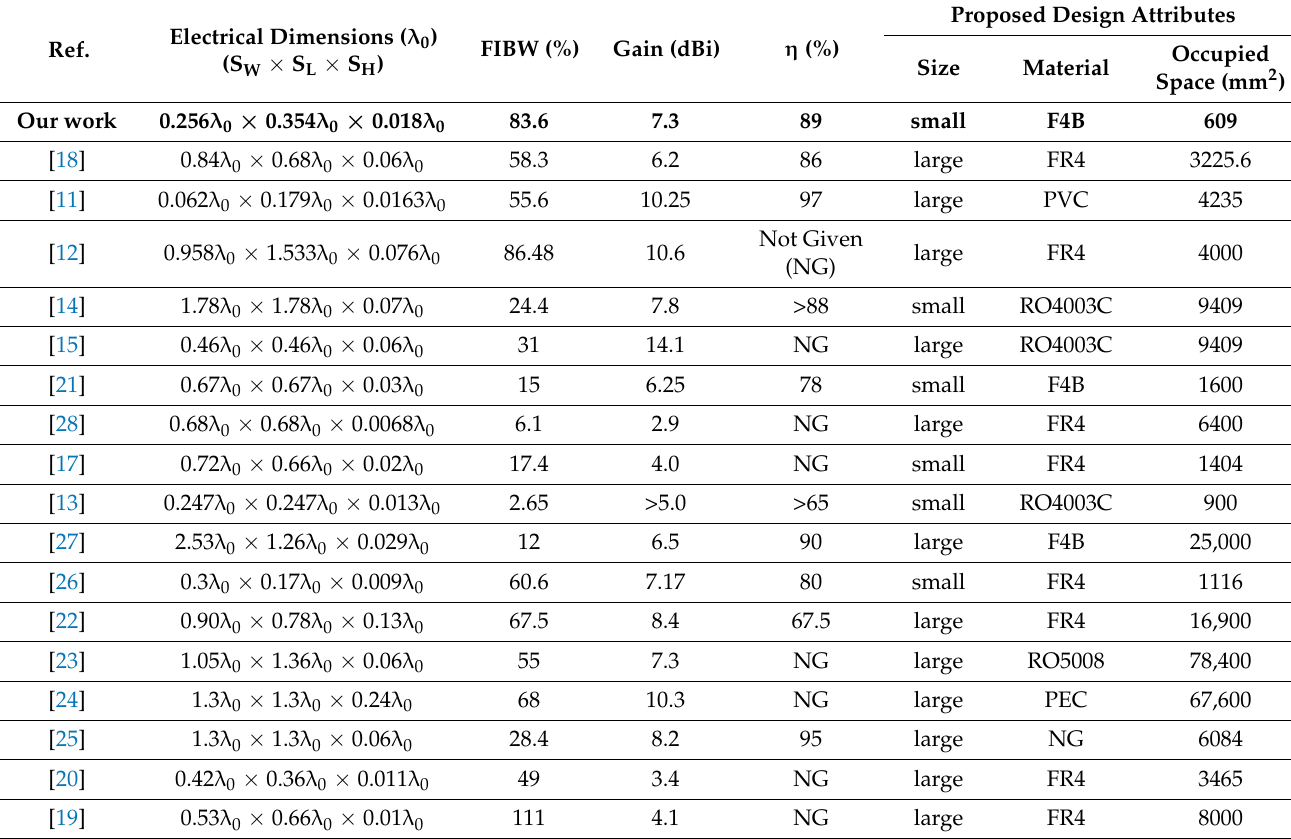
Table 2. Performance comparison between the latest published work and the proposed radiator.